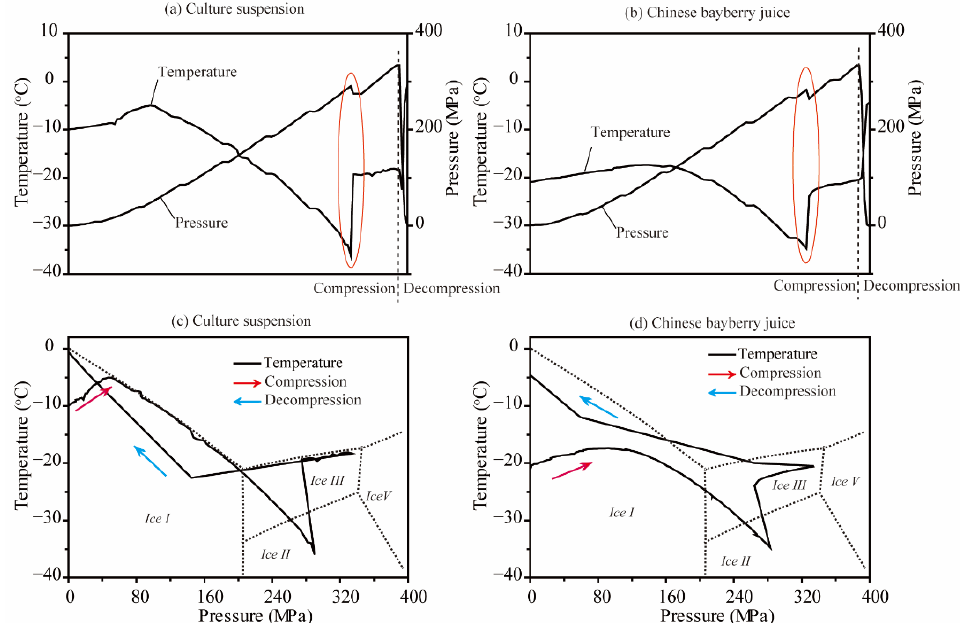
Figure 1. Changes in temperature and pressure of frozen culture suspension and Chinese bayberry juice samples of HP treatment at 330 MPa ( a , b ) and temperature–pressure profiles superimposed on the phase diagram of water ( c , d ).